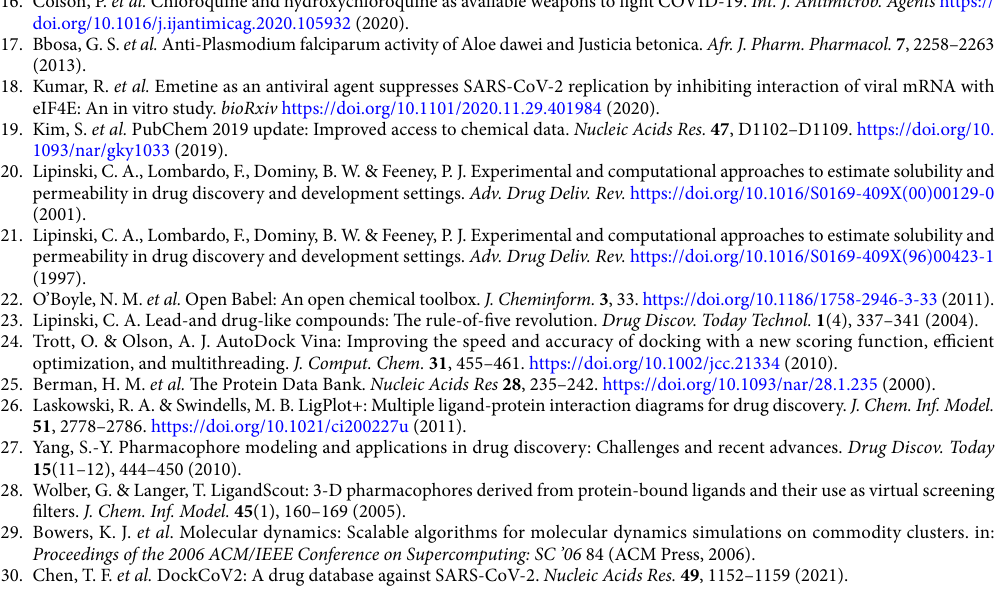
figure creation and writing of the manuscript. S.S. laid the project implementation to its successful execution. All authors have approved the current version of the